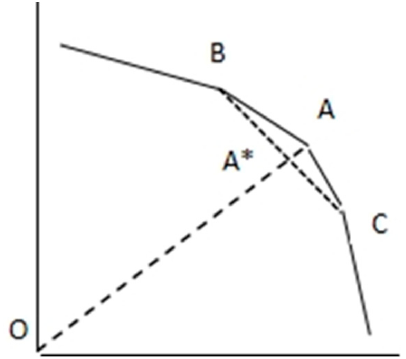
Figure 5. The super-efficiency data envelopment analysis. A*: efficient point.